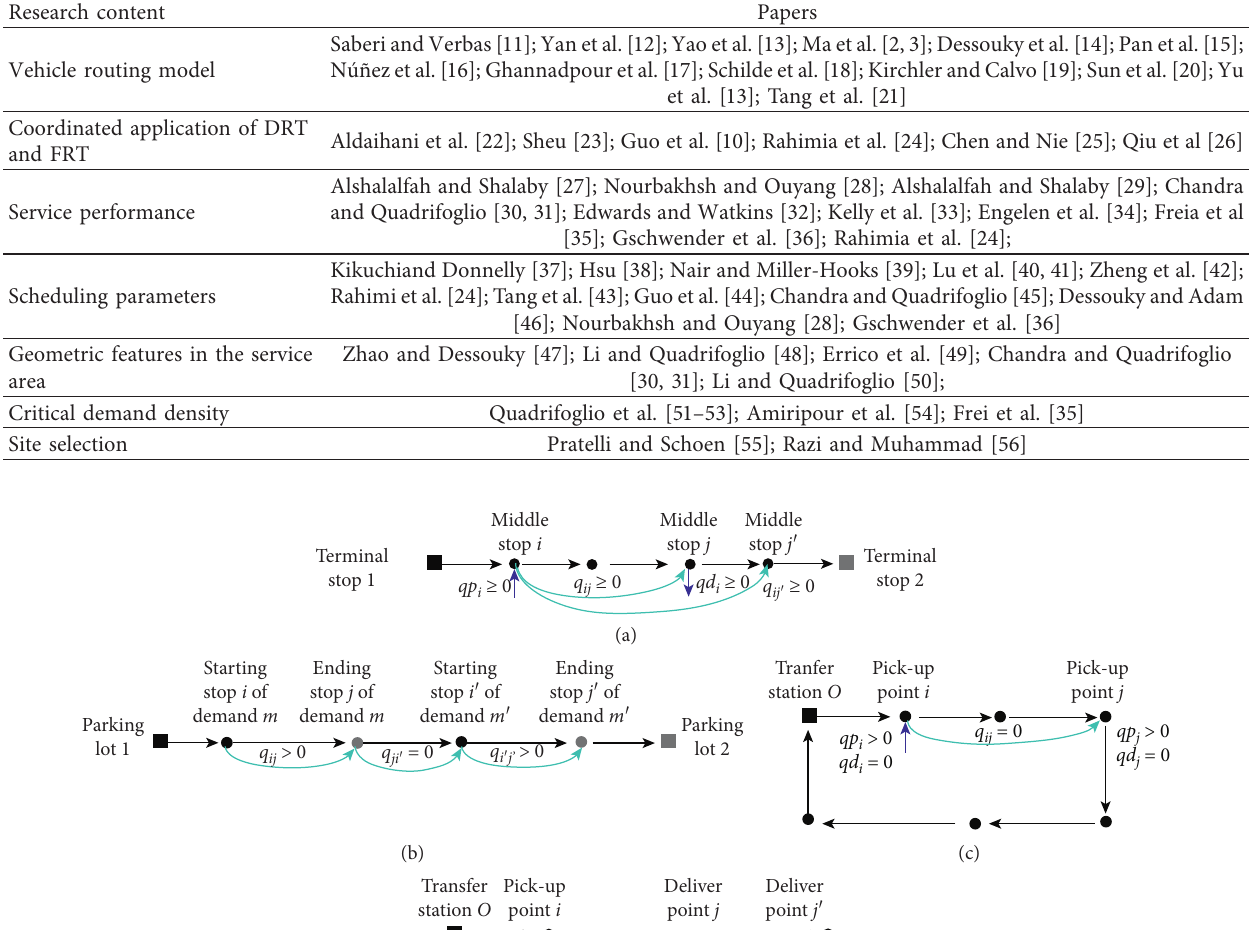
Table 1: A summary of existing studies on DRT.